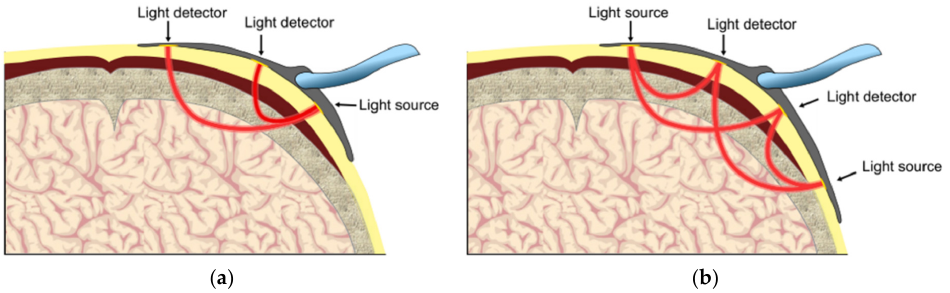
Figure 6. Diagram of the NIRS sensor monitoring light path [10] . ( a ) Single light source; ( b ) dual light source.